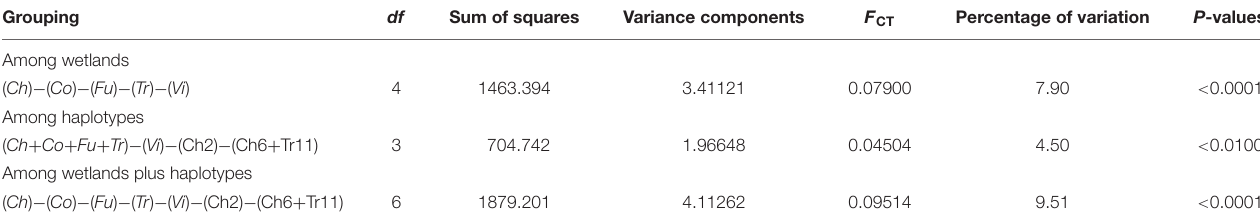
TABLE 4 | Partition of genetic variance among groups of populations. Grouping df Sum of squares Variance components F CT Percentage of variation P -values